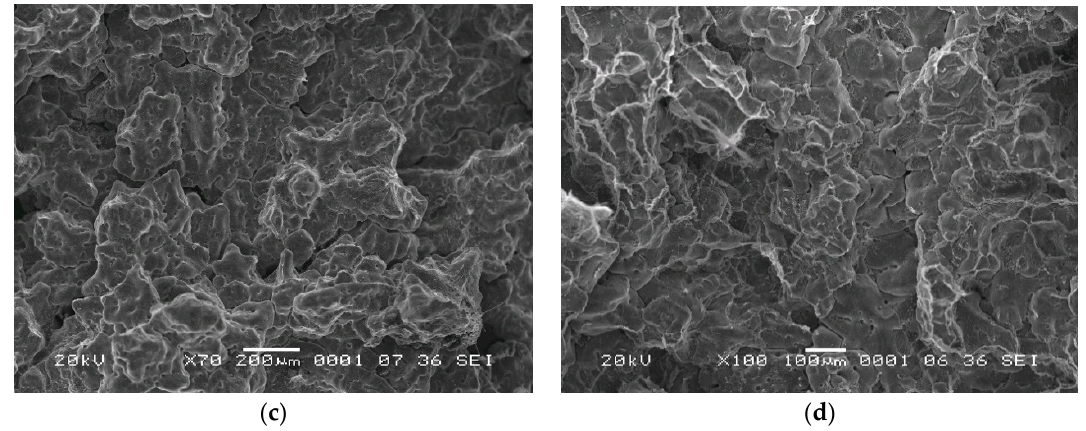
Figure 11. The fracture surface of an as-cast AZ31-2Ca alloy specimen tested in uniaxial tension at Domain #1 area of ( a ) 350 ° C/0.001 s − 1 ; and ( b ) 400 ° C/0.01 s − 1 , showing ductile fracture, and a specimen tested at Domain #2 and the nearby region of ( c ) 500 ° C/0.1 s − 1 and ( d ) 500 ° C/0.001 s − 1 , showing intercrystalline fracture.